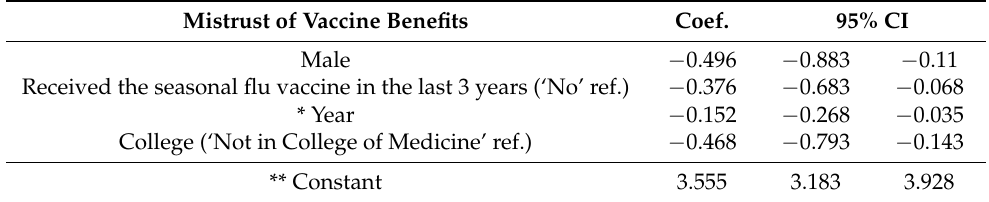
Table 3. Linear regression model of the Mistrust of Vaccine Benefits subscale from the VAX Scale. Mistrust of Vaccine Benefits Coef.